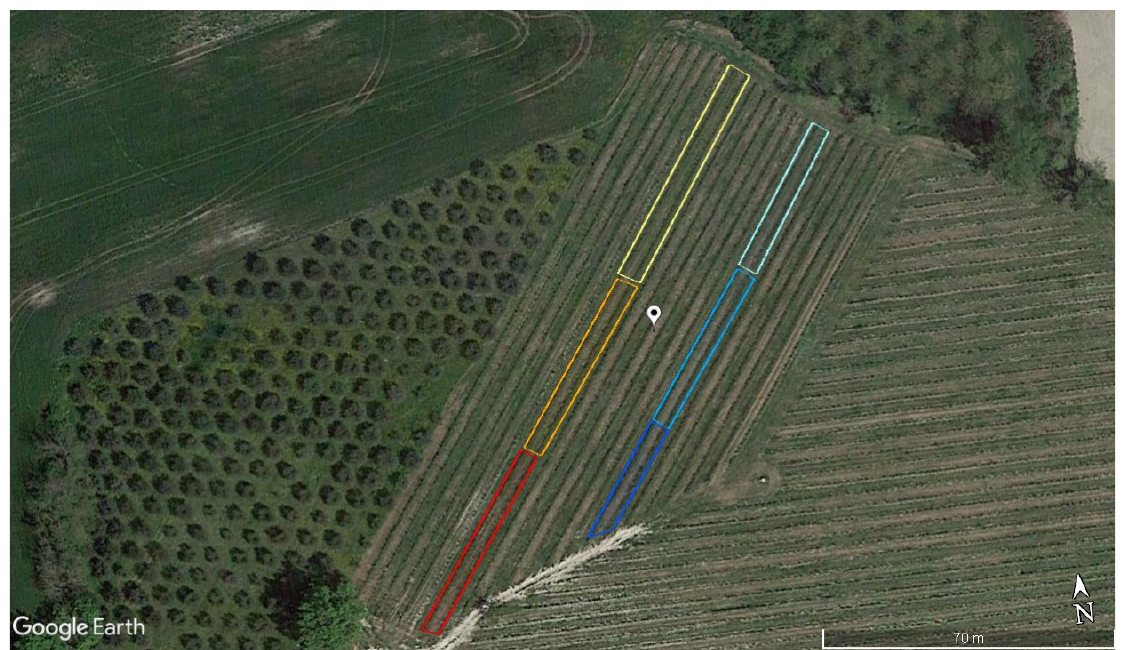
Figure 4. Vineyard rows divided into three blocks for the LiDAR and standard tests: yellow to red blocks are respectively LiDAR blocks from 1 to 3, while light blue to dark blue blocks are respectively Standard blocks from 1 to 3.